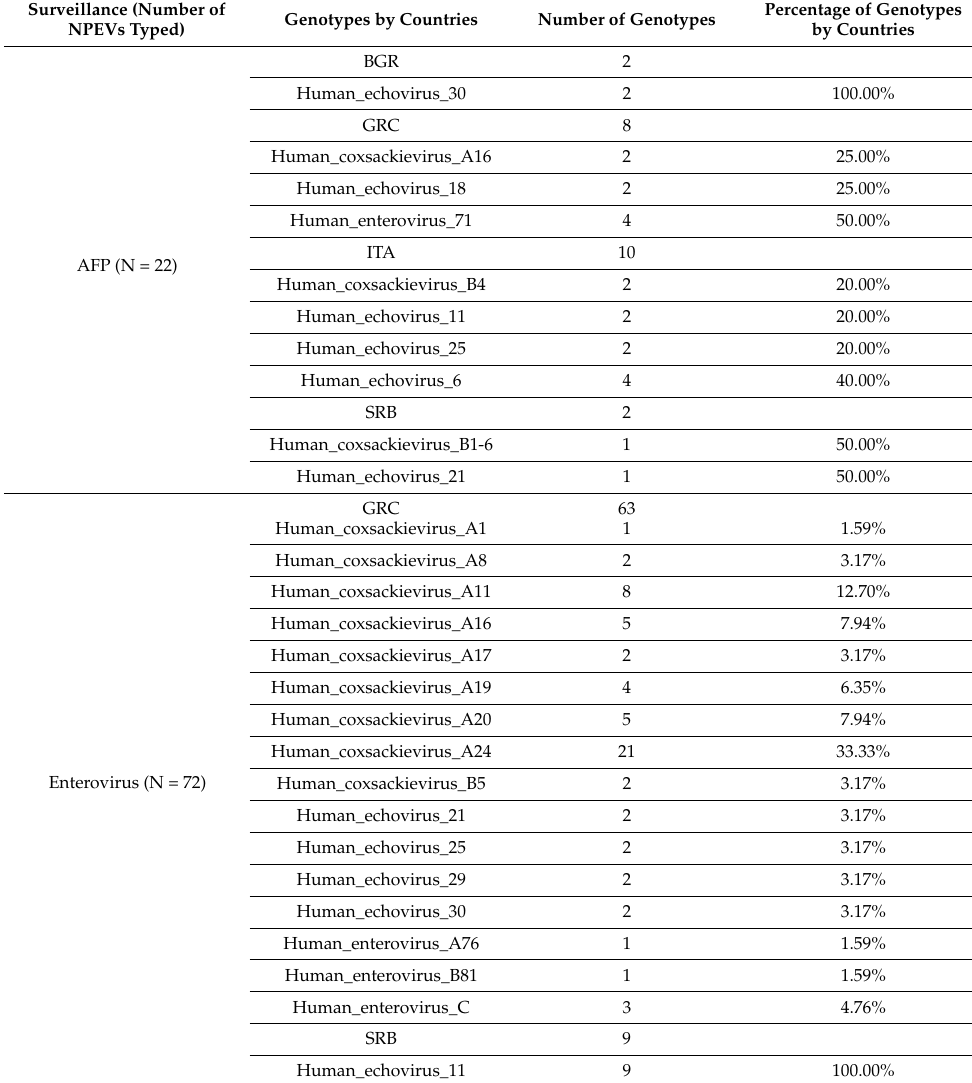
Table 3. Number and percentage of typed NPEVs by surveillance and